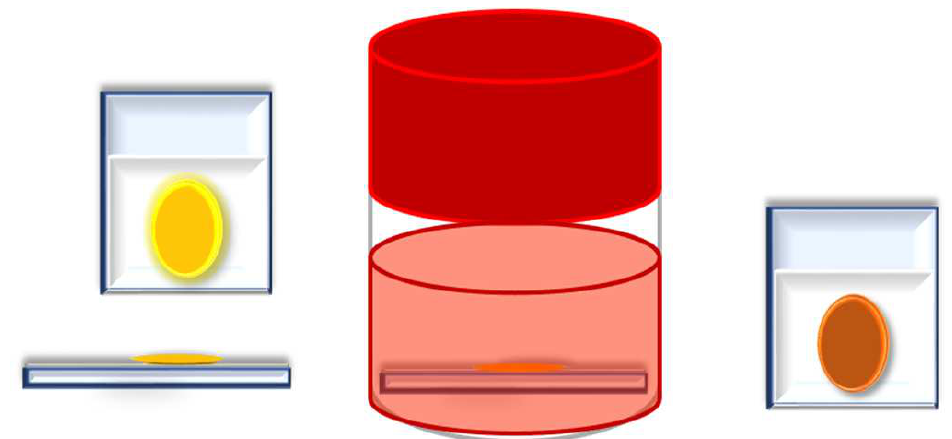
Figure 5. Impregnation of COF as an additive (interface between the dye and photoanode).